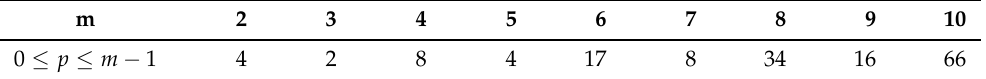
Table 4. The order of the recurrence relation for the Klein bottle KB